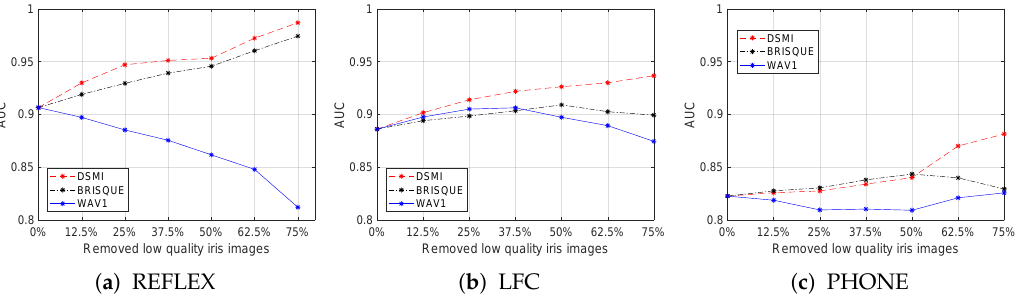
Figure 9. Area under the curve (AUC) values for all iris images after removing different parts of the iris images with the poorest